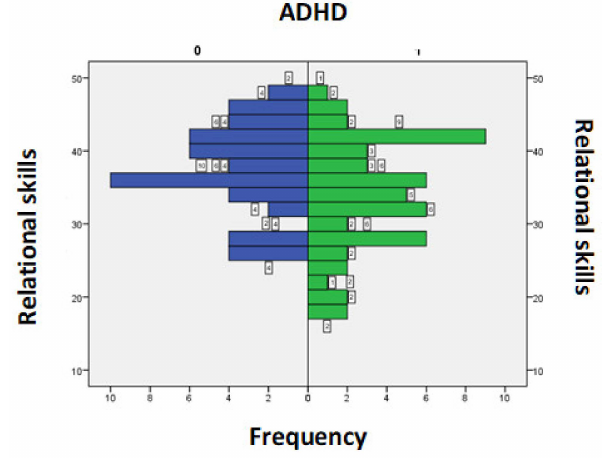
Figure 2. Score for the Relational Skills section according to the presence/absence of ADHD symptoms.